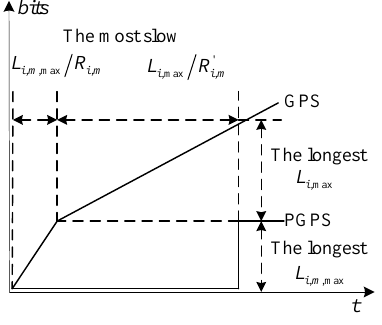
Figure 2: Cumulative function of PGPS and